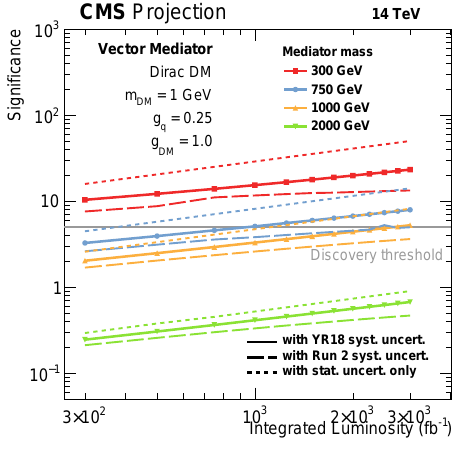
Figure 4: Discovery potential as a function of the HL-LHC integrated luminosity, for Dark Matter vector mediators of various masses in the Z boson + missing energy search channel [ 11 ]